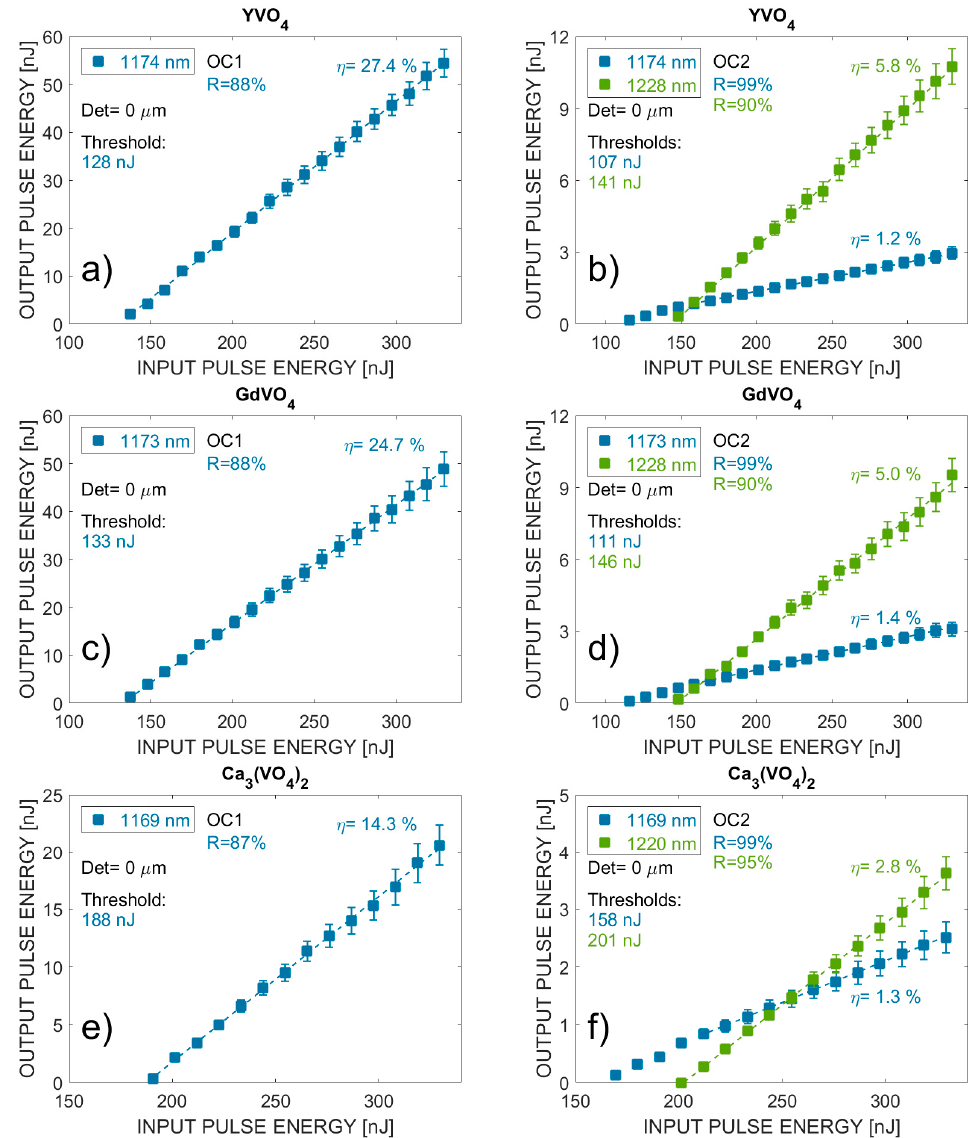
Figure 5. Dependencies of the output SRS pulse energy on the input pump pulse energy in the ( a , b ) YVO 4 , ( c , d ) GdVO 4 , and ( e , f ) Ca 3 (VO 4 ) 2 Raman lasers with ( a , c , e ) OC1 and ( b , d , f ) OC2.